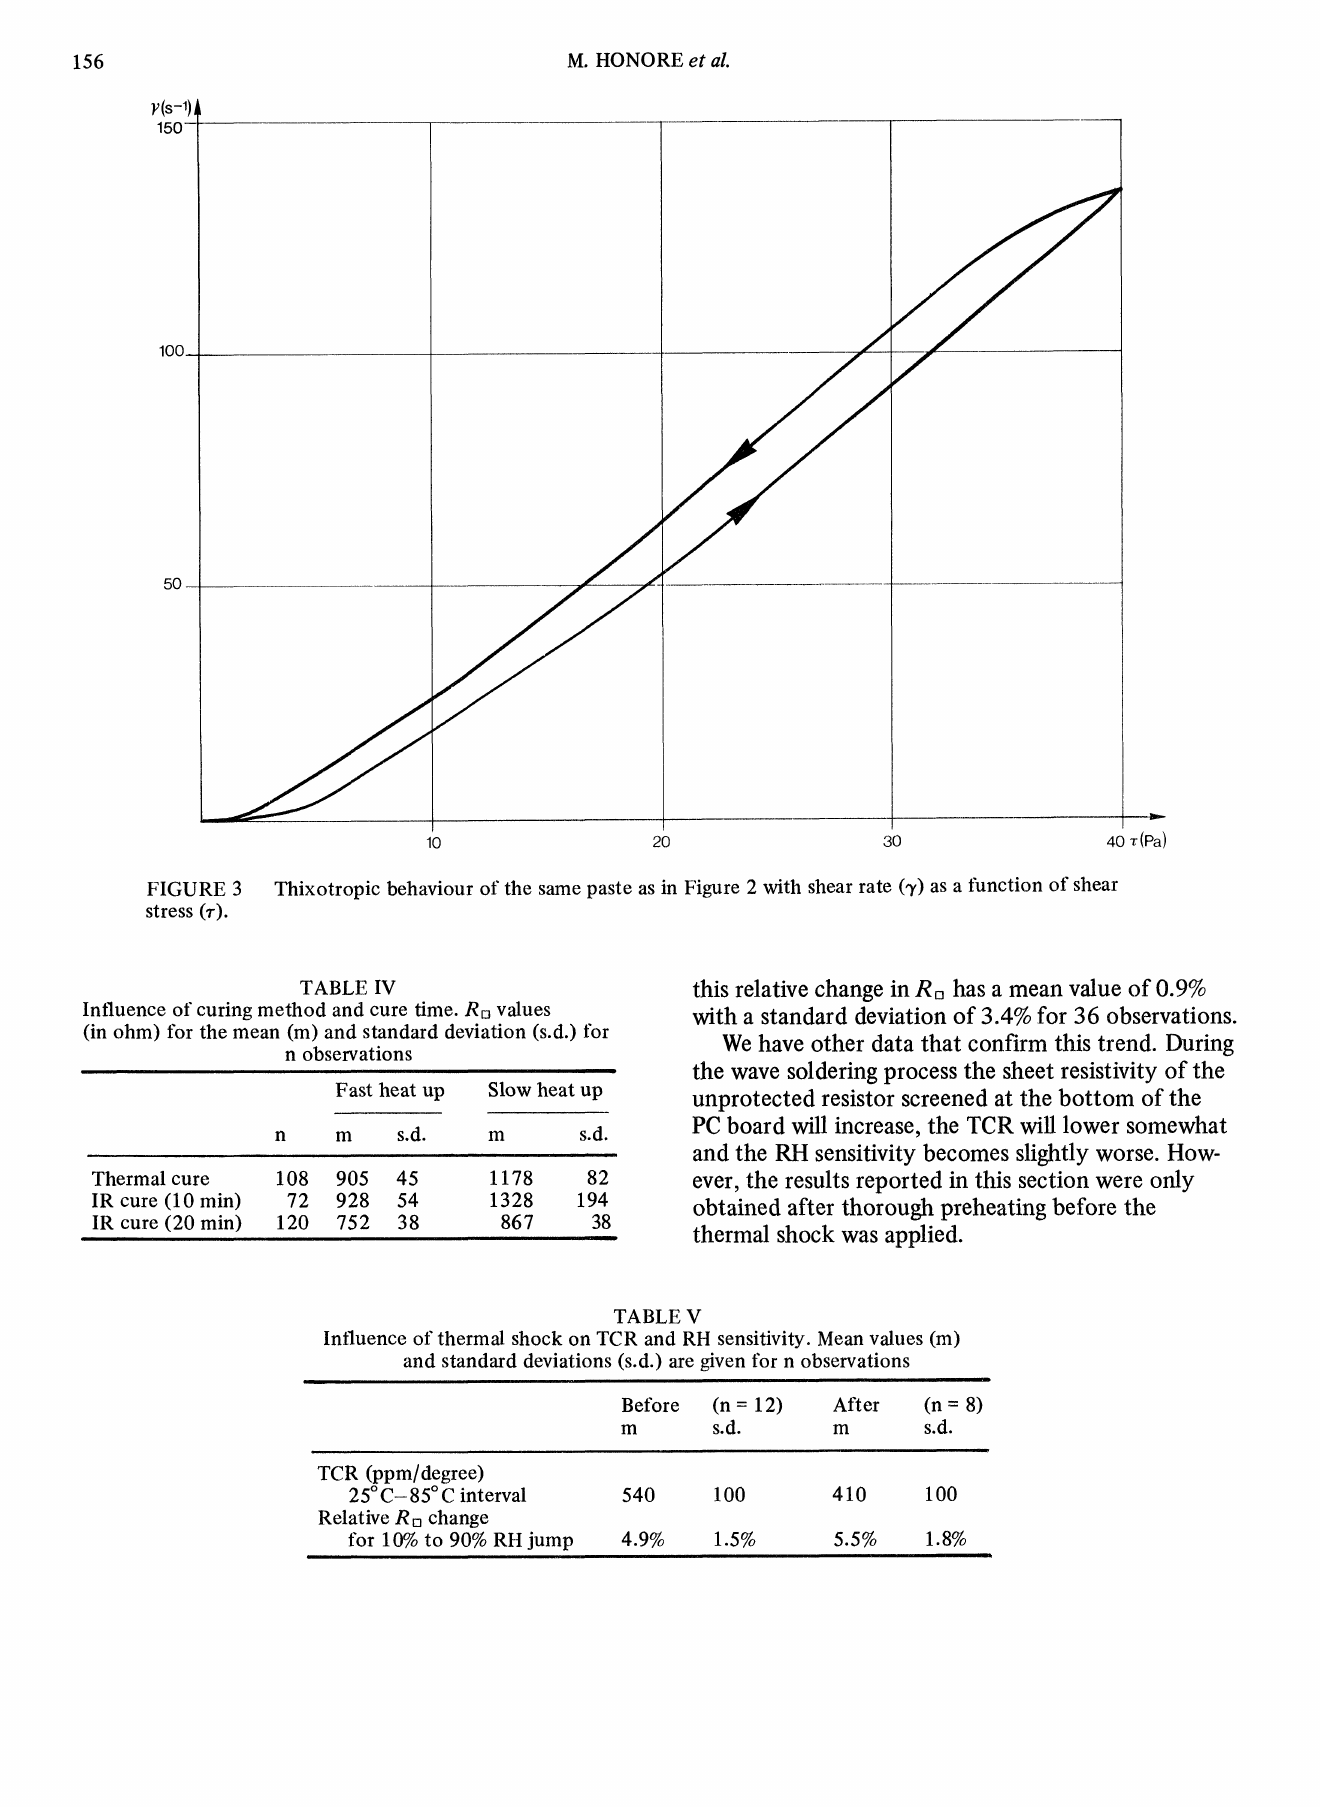
TABLE IV Influence of curing method and cure time. R[] values (in ohm) for the mean (m) and standard deviation (s.d.) for n observations